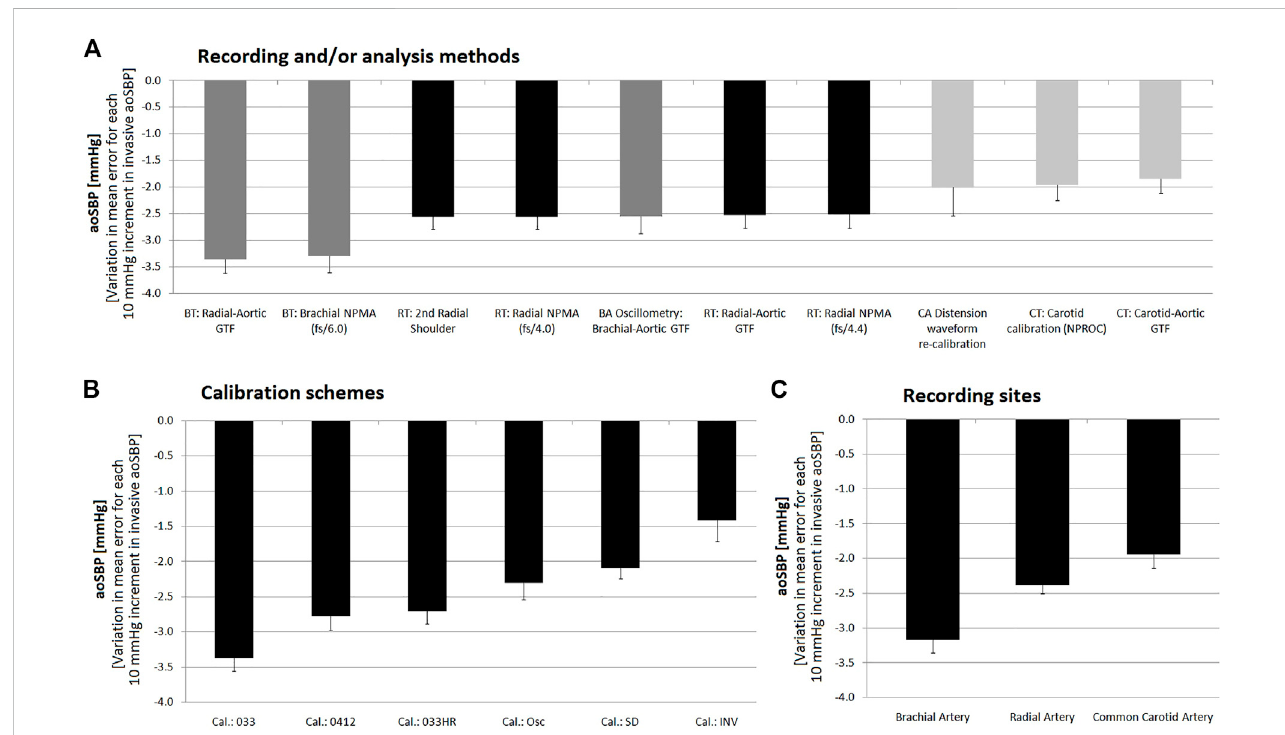
FIGURE 8 PooledresultsforBland-Altmanderivedproportionalerrors(andlowerorupper95%con fi dencelimit)obtainedforcomparissonsbetweennon-invasive and invasive aoSBP measurements. Results grouped according to: (A) , recording and/or analysis method; (B) : calibration scheme; (C) : recording site.